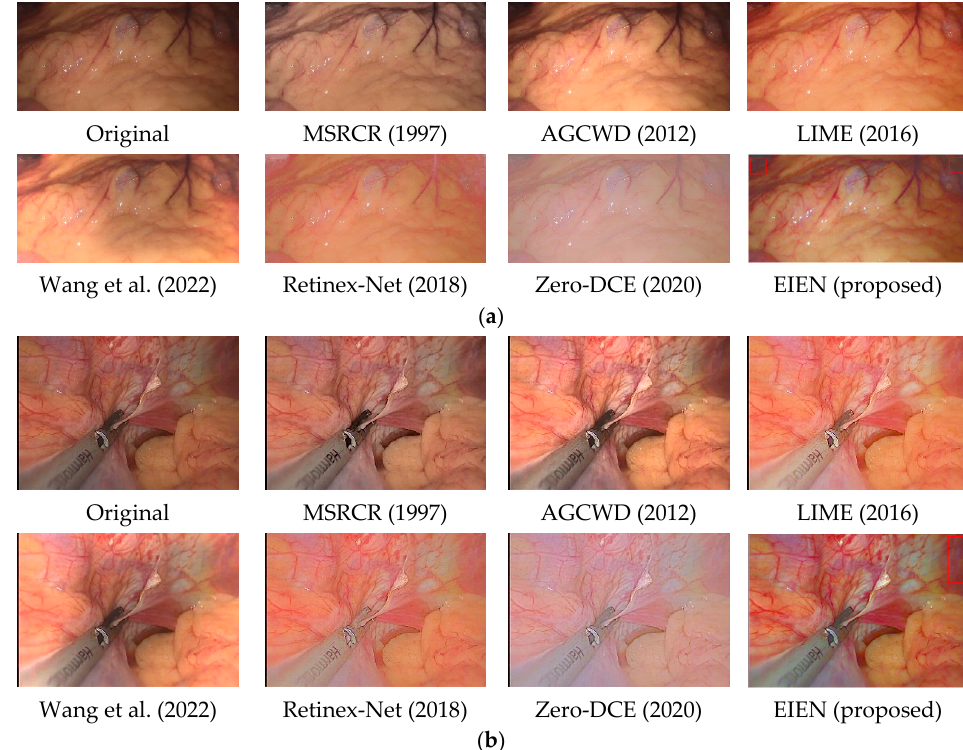
Figure 9. Comparison image of different methods. The two sets of images ( a , b ) include photos of different parts of the human body. The classical image enhancement methods and the enhancement results of the method proposed in this paper are shown. The red box is the case where the local enhancement effect is not good [6,9,11,12,14,16].